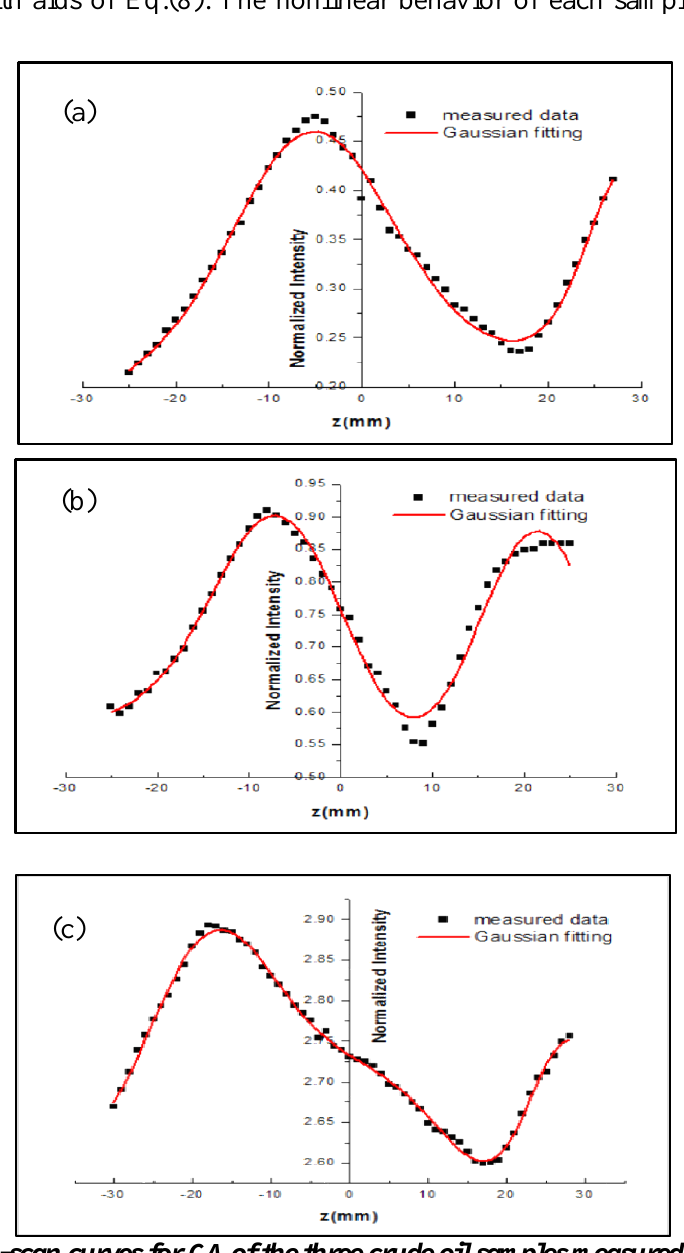
Fig.2: The Z-scan curves for CA of the three crude oil samples measured at 632.8